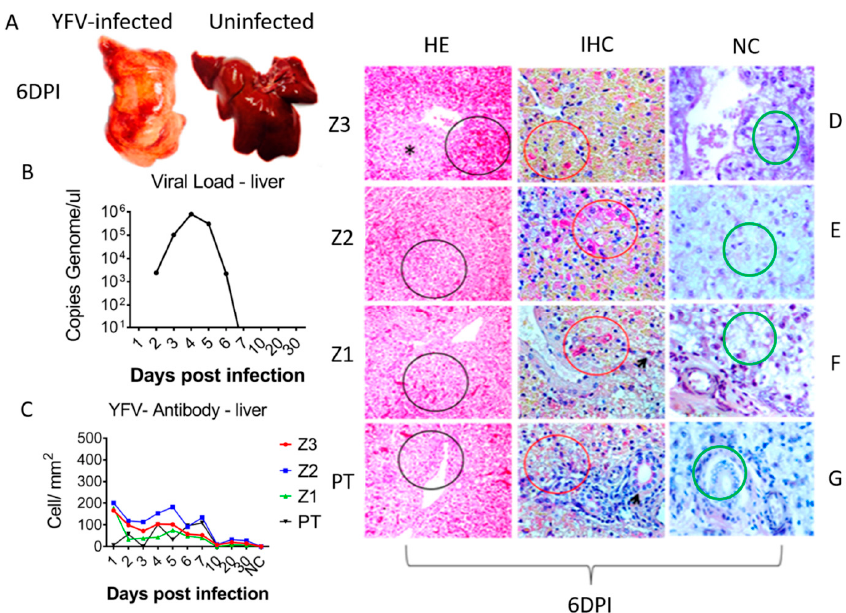
Figure 1. Gross macroscopy, viral load, histopathology and immunohistochemical assay in hepatic parenchyma of squirrel monkey ( Saimiri spp.) infected with YFV South American genotype I. ( A ) Macroscopic representation of liver infected with YFV at 6 dpi showing an icteric and hemorrhagic pattern compared to a normal uninfected liver. ( B ) Evolution of viral kinetics highlighting viremic peak at 4 dpi. ( C ) Quantification of cell expressing specific YFV antigens by Immunohistochemical assay (IHC) in the 4 hepatic compartments analyzed demonstrating a wide predominance in Z2 during the acute phase of infection. ( D ) Representative histopathology photographs showing the involvement of Z3, with emphasis to lytic necrosis (asterisks), intense hemorrhage (black circle), positive immunohistochemistry for presence of specific YFV antigens in hepatocytes (red circle). ( E ) Histopathology showing the major involvement of Z2 with lytic necrosis area (black circle), positive immunohistochemistry showing large amounts of YFV antigens in hepatocytes (red circle). ( F ) Representative histopathology photographs of Z1, showing areas of periportal lytic necrosis and hemorrhages (black cycle), positive immunohistochemical for defection of specific YFV antigens and a periportal infiltrate is highlighted (red circle) and Kupffer cells (arrow). ( G ) Representative histopathology photographs of portal tract (PT) showing inflammatory infiltrate (black circle), positive immunohistochemistry for YFV antigens periportal infiltrate (red circle) and in the bile duct (black arrow); ( D – G ) Negative control for YFV antigens in Z3, Z2, Z1, and